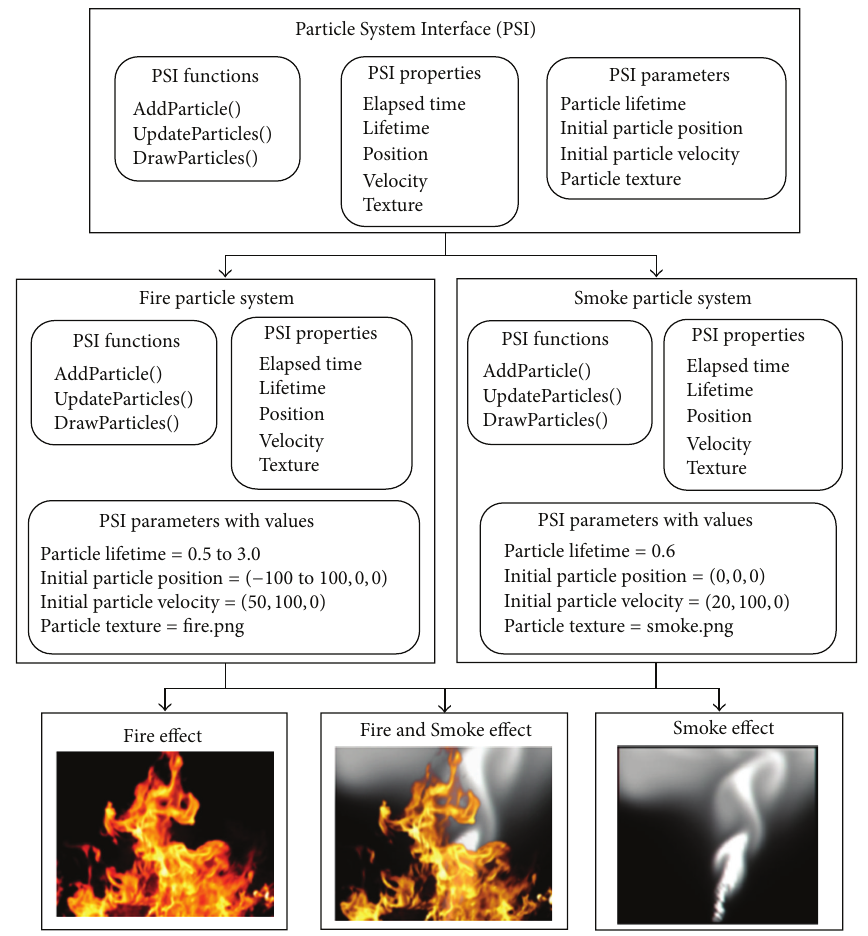
Figure 1: One Particle System Interface, creating two particle systems and creating three